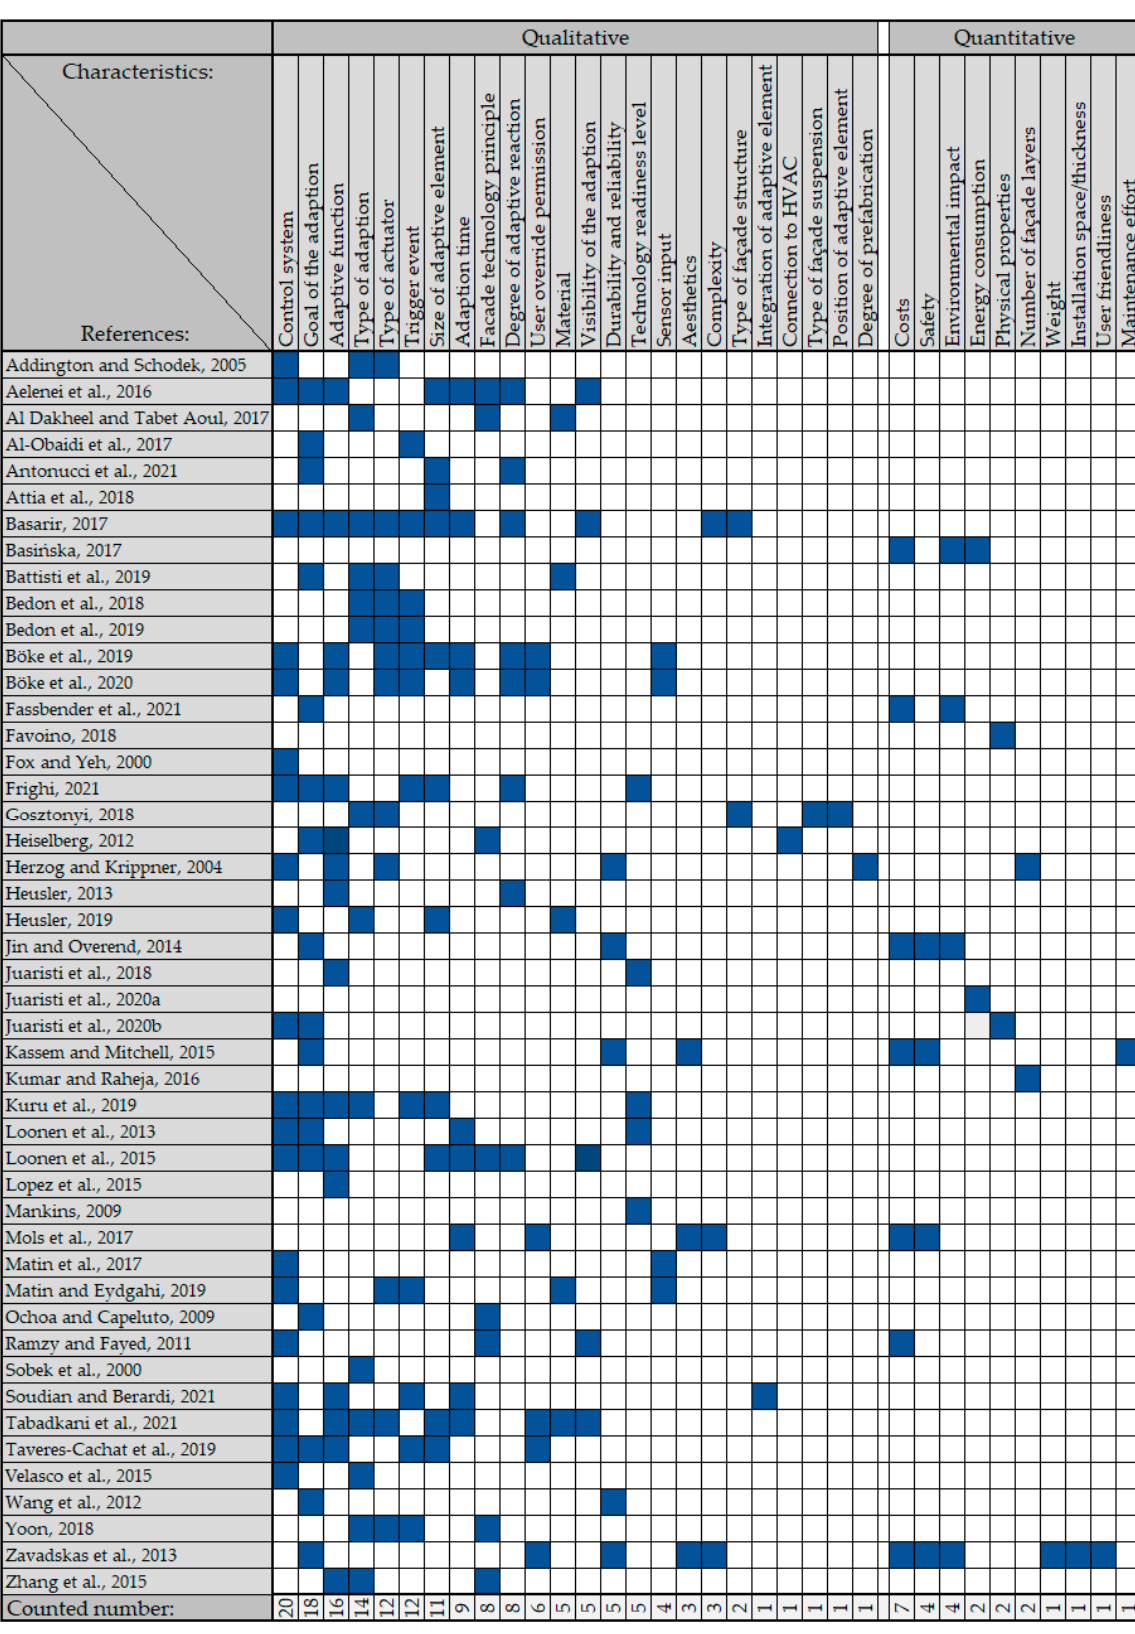
Figure 7. Comprehensive set of main characteristics of adaptive façades [1,3,4,18,19,21,22,37,41,42,46,47,49–51,54–85], refined from [23].